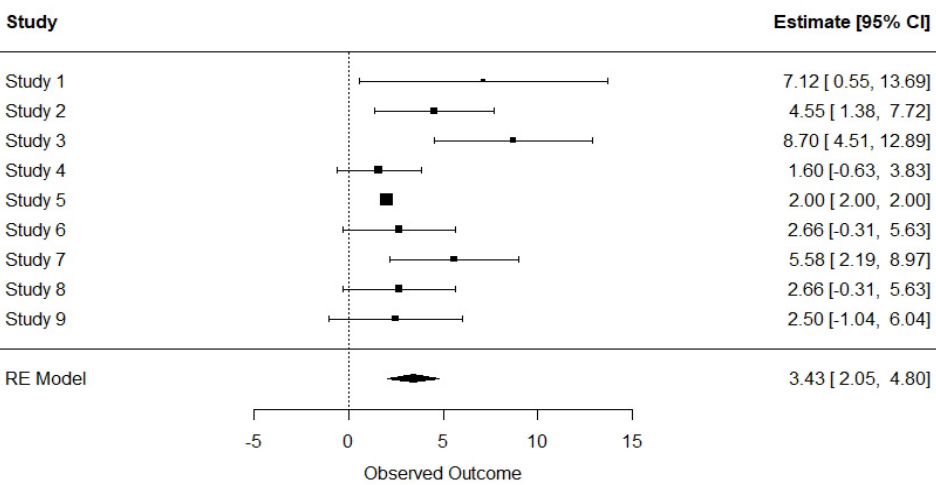
Figure 13. Forest plot evaluating leaf folder-damaged leaves. For each study, a horizontal line indicates the standard effect size of leaf folder-damaged leaves estimate (the rectangular box in the centre of each line) and 95% CL for the risk ratio used. The diamond represents the combined estimate of all the studies and its 95% confidence interval (width). Study 1: Pathak et al., 2013 [24]; Study 2: Karthikeyan et al., 2014 [3]; Study 3: Karthikeyan et al., 2010 [30]; Study 4: Padmavathi et